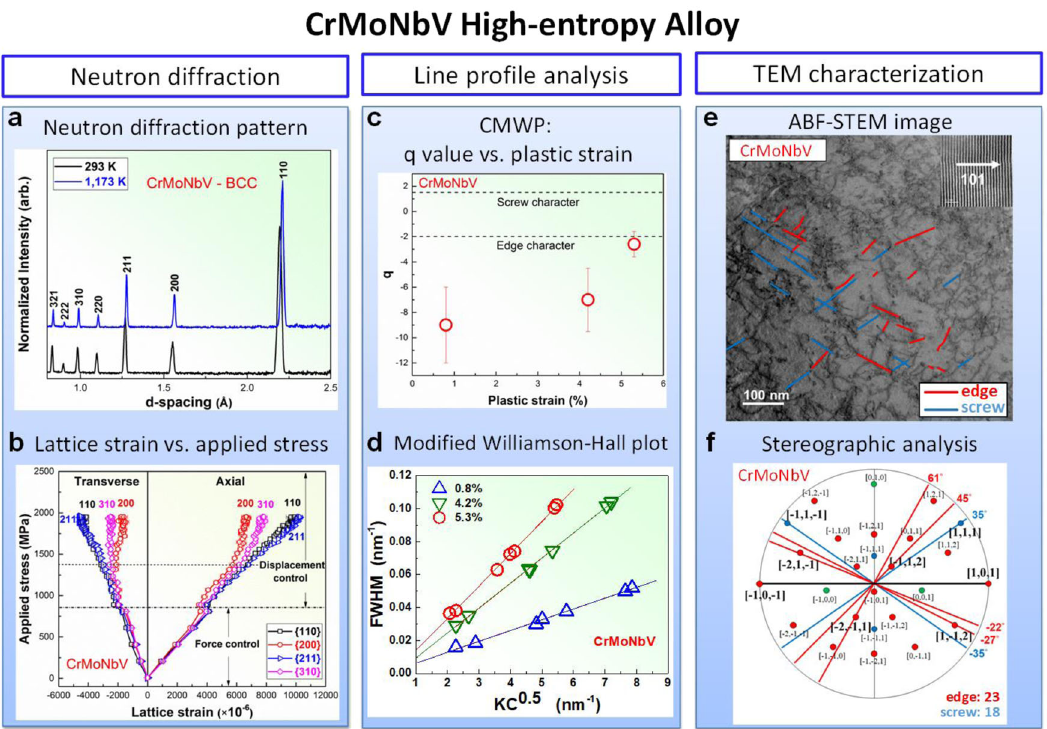
Fig. 3 Neutron diffraction and TEM experiments showing the dominance of edge dislocations in CrMoNbV. a Neutron-diffraction patterns presenting interplanar spacings with peaks indexed for the BCC structure of CrMoNbV, at temperatures of 293 and 1173 K. b Axial and transverse lattice strains versus applied load, shown as the applied stress versus lattice strain so that the slopes correspond to the planar Young ’ s moduli ð E hkl Þ and Young ’ s moduli/ = ν Þ , as indicated for the {110}, {200}, {211}, and {310} planes, respectively, at T = 293 K. The onset of plastic yielding (yield stress) Poisson ’ s ratios ð E hkl hkl is presented as the dashed line. c Evolution of q parameters as a function of plastic strain, which is obtained from the Convolutional Multiple Whole Pro fi le (CMWP) fi tting. Dashed lines indicate values of q parameters for edge and screw character dislocations, considering a 15% error margin for the elastic constants. The error bars in the q-parameter values are determined by the fractions of edge or screw dislocations. d Modi fi ed-Williamson-Hall plot, FWHM versus KC 0 : 5 at plastic strains of 0.8%, 4.2%, and 5.3%, respectively, at T = 293 K. The plots were obtained from the physical pro fi les calculated by the CMWP procedure, considering free of the instrumental effects on the FWHM data. The pattern of the undeformed specimen was applied to the CMWP procedure as an instrumental pattern. The much better agreement of the data with the edge analysis demonstrates th e dominance of edge dislocations. e Annular-Bright- fi eld (ABF)-STEM image of CrMoNbV at a plastic strain of 4.2% with a two-beam condition near Z ¼ ½ (cid:1) 101 (cid:3) and g ! ¼ ð 101 Þ . All straight dislocation lines longer than 5 nm are highlighted by blue and red lines, corresponding to their identi fi cations as edge and screw dislocations, respectively. f Stereographic projection related to the [ (cid:1) 101] orientation, where [101] has been aligned with images in ( e ). All possible dislocations are indicated, and those corresponding to the images in ( e ) are highlighted in bold. The degrees indicate the angles with respect to the [101] direction. Blue lines/blue symbols present those dislocations identi fi ed as edge, and red lines/symbols indicate those dislocations identi fi ed as screw. The green lines/symbols represented the dislocations that could be either edge or screw, which was excluded in the ratio calculation. As a result, ~55% of the dislocations are identi fi ed as